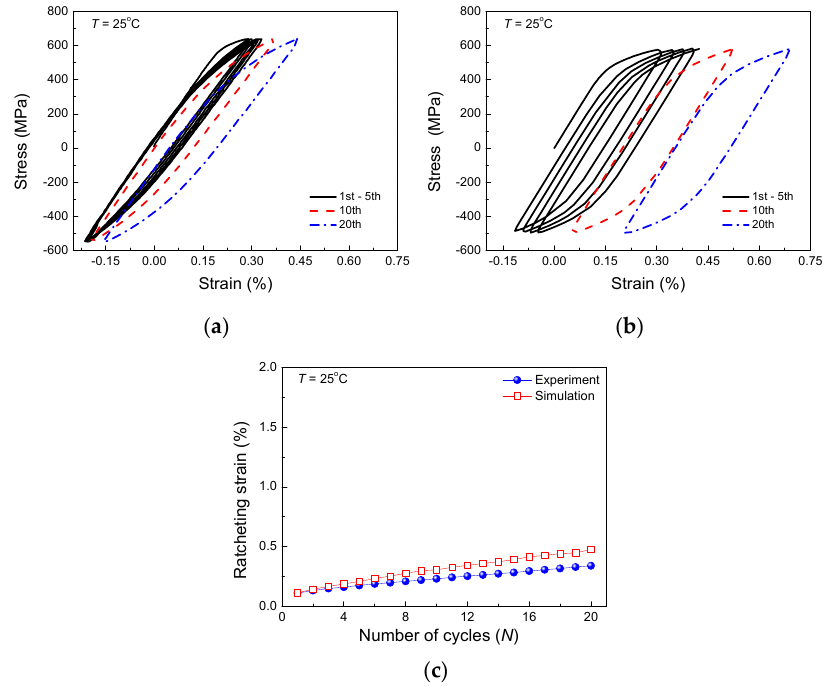
Figure 7. Results of the notched bar at 25 °C: ( a ) experimental stress-strain curves, ( b ) simulated stress-strain curves and ( c ) experimental and simulated ratcheting strains versus number of cycles.